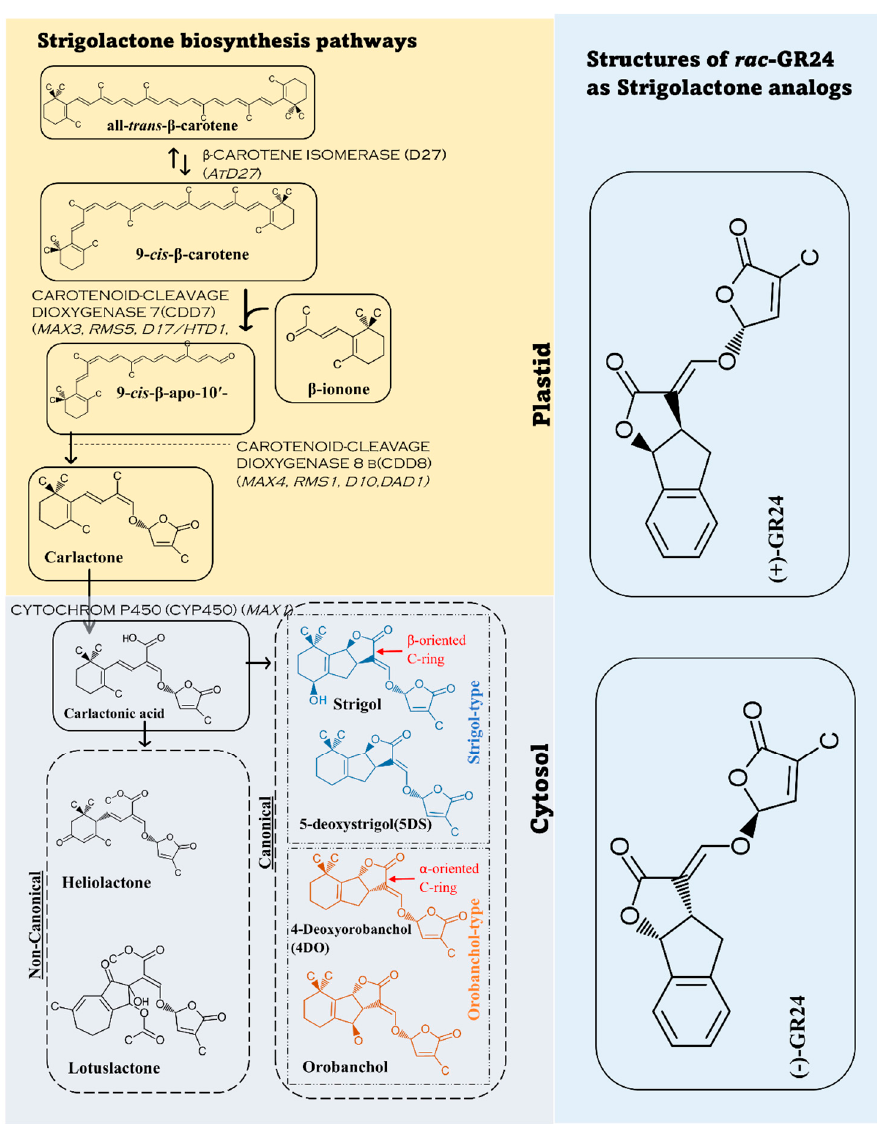
Figure 1. Strigolactone biosynthesis from carotenoids. In plastids all– trans – β –carotene goes through different enzymatic reactions to carlactone. Then, the carlactone transforms to form carlactonic acid in the cytosol (cytoplasm) to form various forms of strigolactones. The figure demonstrates two common examples of SLs in non-canonical form, four common ones of canonical form and the most common strigolactone analog,